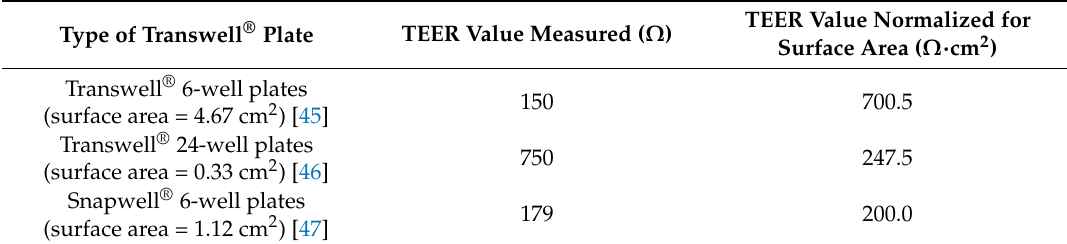
Table 1. Required transepithelial electrical resistance (TEER) values, as indicative of the intact Caco-2 cell monolayers, on different Transwell®plate insert